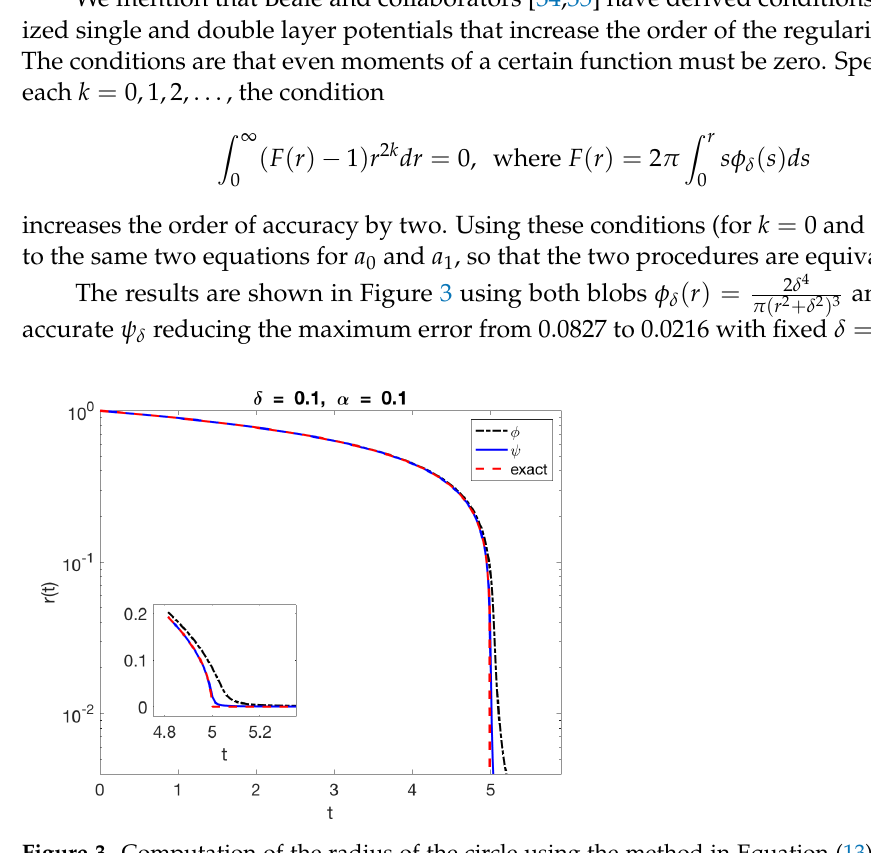
Figure 3. Computation of the radius of the circle using the method in Equation (13) and the two blobs φ δ ( r ) (dash-dot) and ψ δ ( r ) (solid) from Table 1. The dashed curve is the exact solution of the problem. The radius is shown in logarithmic scale to appreciate the difference between the solutions. The inset shows the results in linear scale near t = 5, when the exact solution shrinks to a